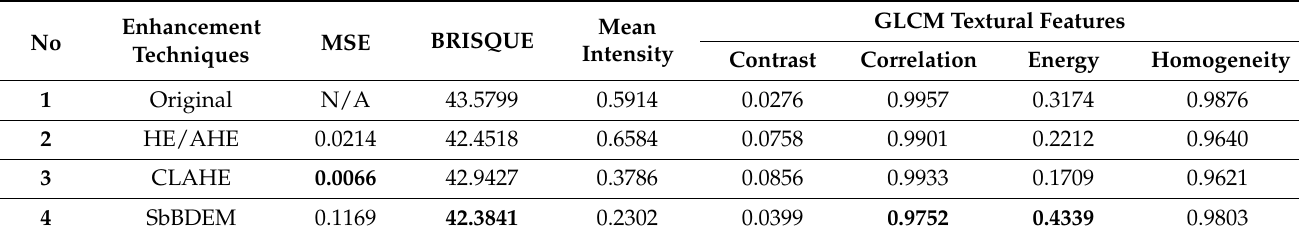
Table 1. Average Quality Tests and GLCM features on INbreast Images (N=112) using Enhancement Techniques.